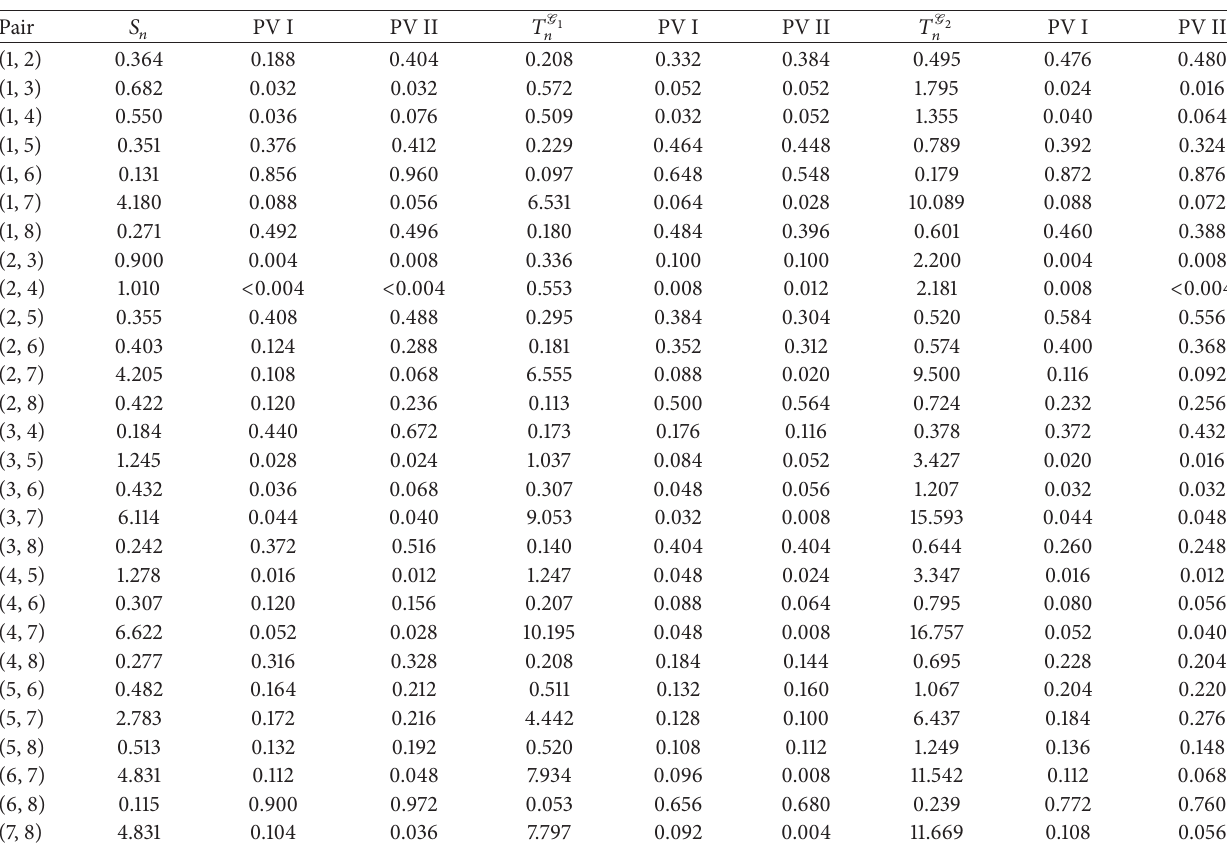
Table 5: Data analysis of each pair in the eight-dimensional Oil currency dataset: value of the Cram´er-von Mises statistic 𝑆 𝑛 and of